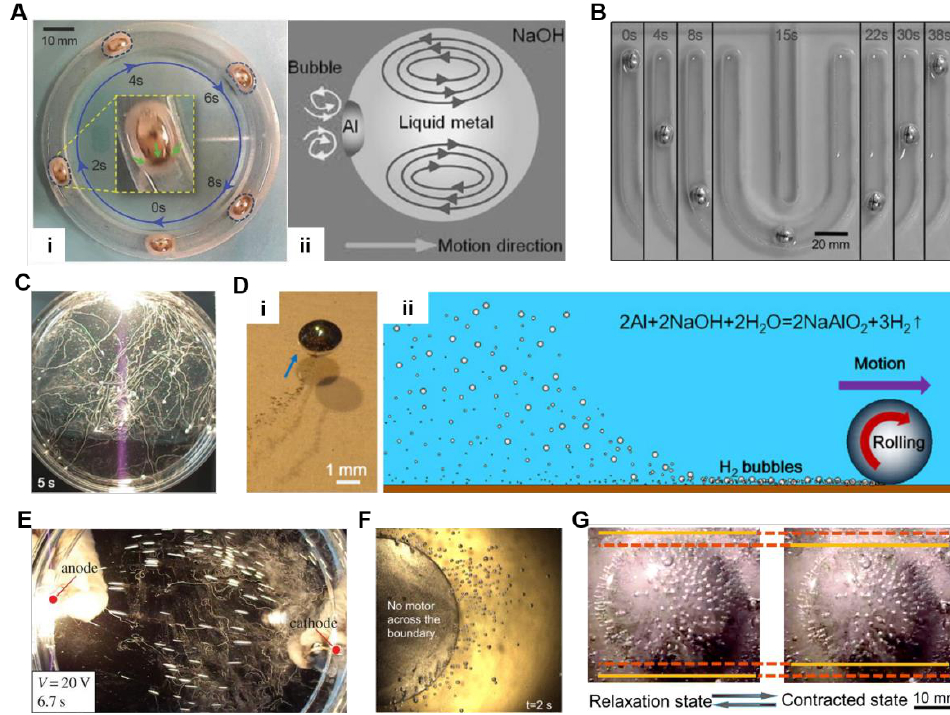
Figure 6. Self-powered liquid metal (LM) droplets. ( A ) Self-fueled LM droplet running in a circular channel and the schematic diagram of the propulsion mechanism. Reprinted with permission from ref. [68]. Copyright, 2015, John Wiley and Sons. ( B ) Self-driven motion of LM in U-shaped channel. Reprinted with permission from ref. [68]. Copyright, 2015, John Wiley and Sons. ( C ) Irregular motion of LM droplets. The curves in the figure are the trajectory of droplets. Reprinted with permission from ref. [28]. Copyright, 2015, Elsevier. ( D ) Optical image and schematic diagram of self-powered LM droplet motor. Reprinted with permission from ref. [28]. Copyright, 2015, Elsevier. ( E ) The controllable motion of LM droplet motors. Reprinted with permission from ref. [30]. Copyright, 2015, The Royal Society (U.K.). ( F ) LM droplet motors trapped in the boundary zone of the magnet. Reprinted with permission from ref. [106]. Copyright, 2015, AIP publishing. ( G ) The oscillation process of LM droplets in one oscillation cycle. Reprinted with permission from ref. [107]. Copyright, 2019, The Royal Society of Chemistry.